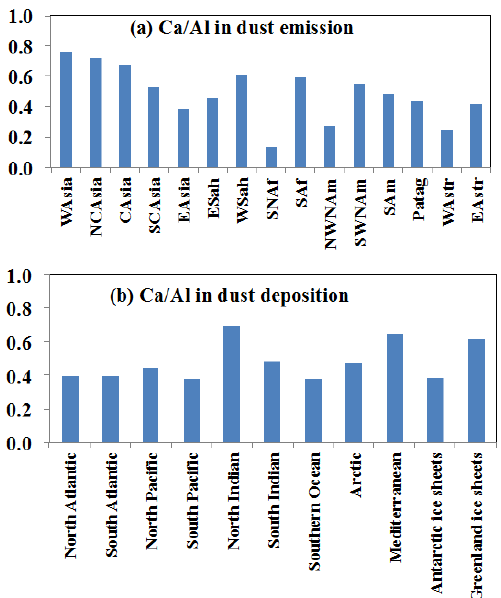
Figure 9. Ten-year averaged Ca / Al ratio in (a) dust emission of source regions and (b) dust deposition into various ocean basins and glaciers. Elemental ratios are calculated using the annual mean emission of Ca divided by the annual mean emission of